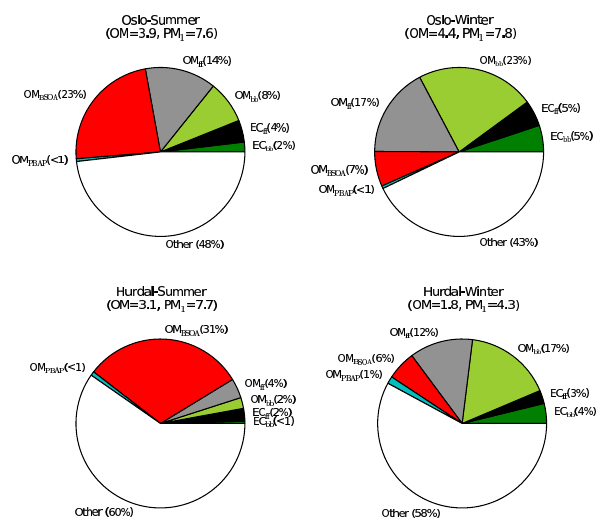
Fig. 2. Estimated contribution of carbonaceous matter components to PM 1 . Estimates use central values from LHS analysis. OM, PM 1 numbers in parenthesis give total aerosol concentrations and OM in µgm − 3 . See Sect. 5.7 for assumed OM:OC ratios.